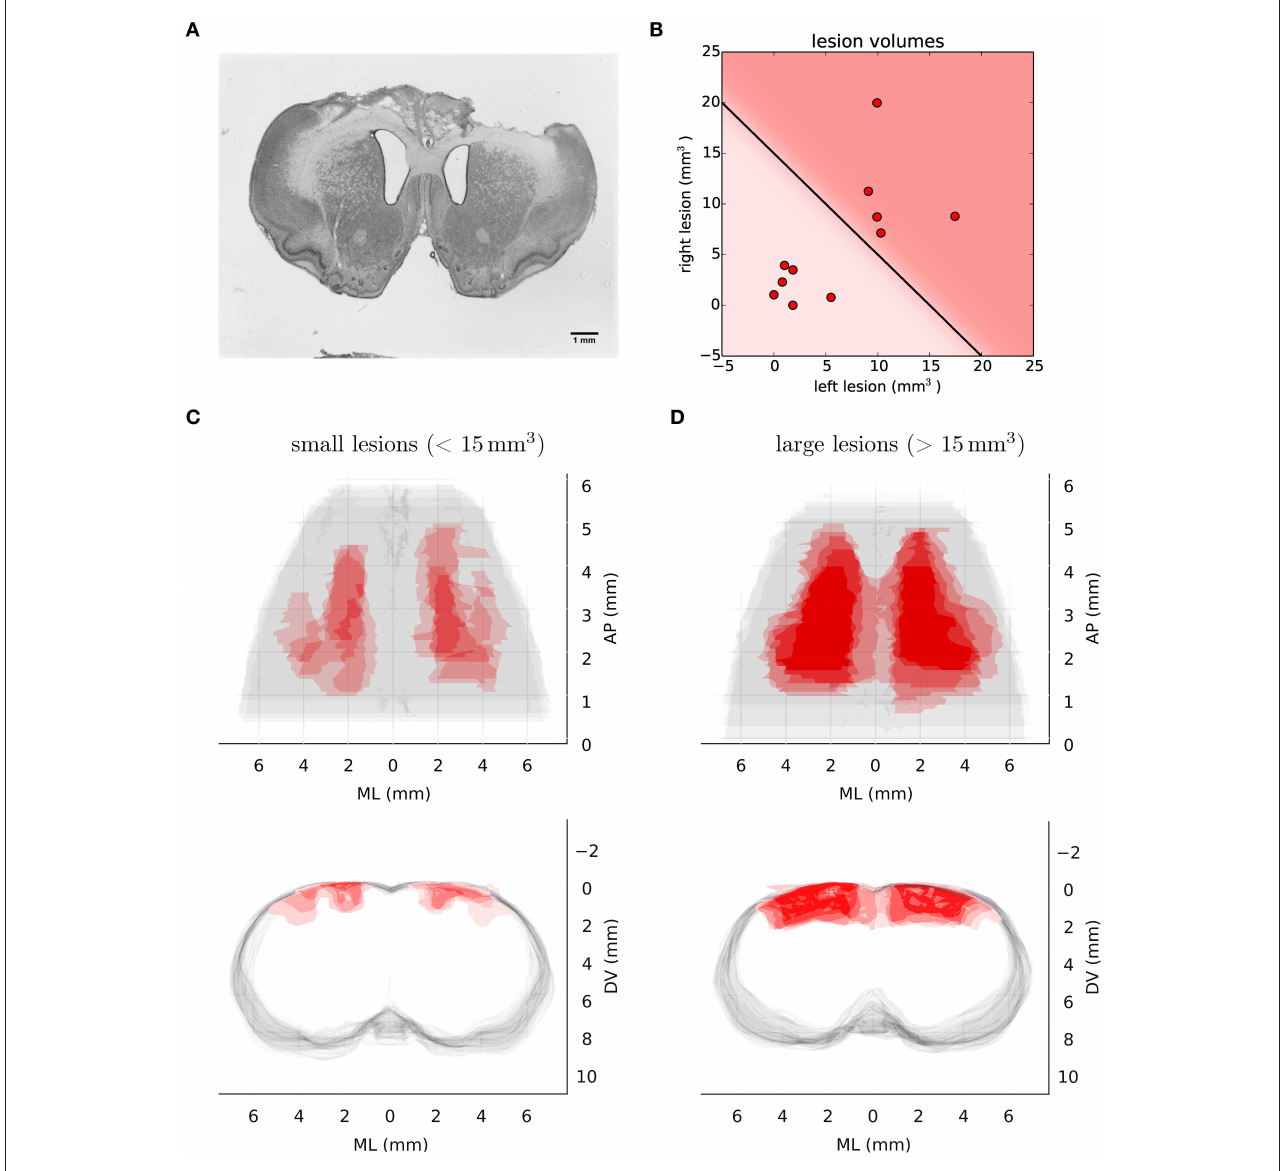
FIGURE3 Histological analysis of lesion size. (A) Representative example of Nissl-stained coronal section showing bilateral ibotenic acid lesion of primary and secondary forelimb motor cortex. (B) Distribution of lesion volumes in the left and right hemispheres for individual animals. A lesion was considered “large” if the total lesion volume was above 15mm 3 . (C) Transverse (upper) and coronal (lower) views of super-imposed reconstruction stacks for all the small lesions ( n = 6). (D) Transverse (upper) and coronal (lower) views of super-imposed reconstruction stacks for all the large lesions ( n =